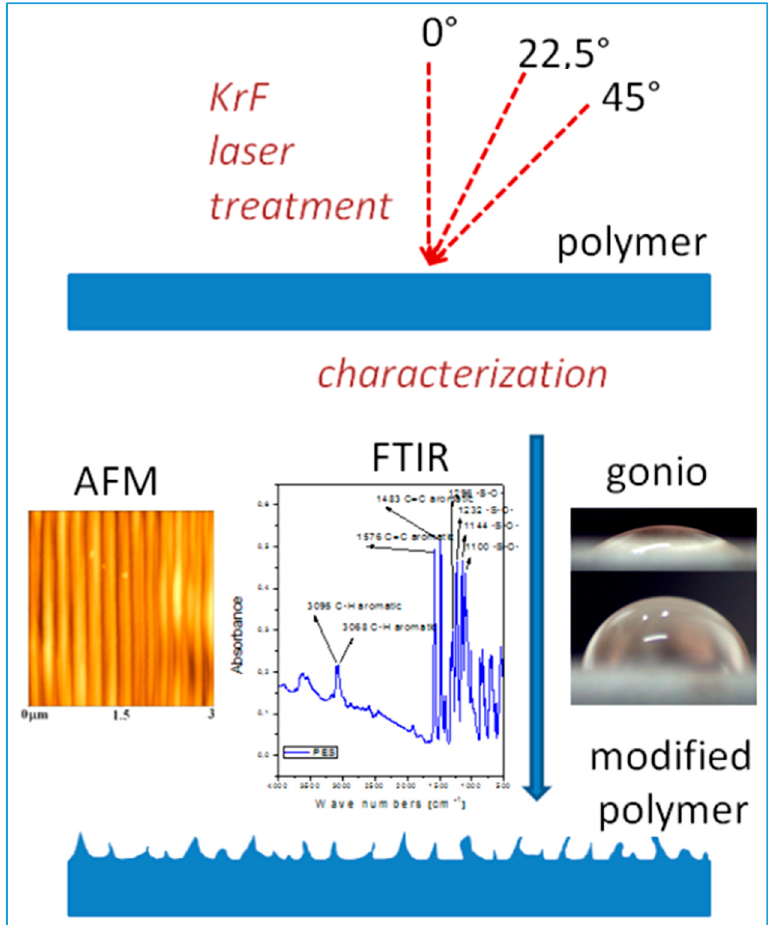
Figure 1. Scheme of the laser treatment process and surface evaluation on polymers such are polyethersulfone (PES), polyetherimide (PEI) and polyetheretherketone (PEEK). The samples treated by KrF laser beam under different angles (perpendicular which corresponds to 0° and sample rotation under the angles of 22.5 or 45°) create various surface morphologies. The modified substrates were characterized by goniometry, UV-Vis and FTIR spectrometry and by AFM [31].